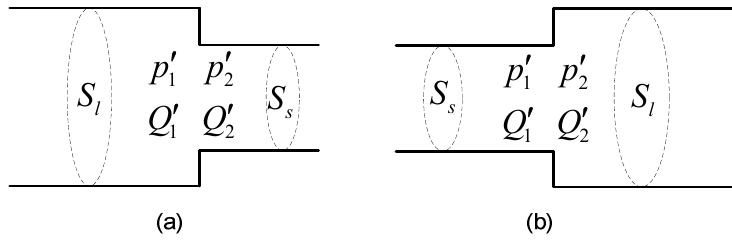
Fig. 5 Schematic of area discontinuities: (a) area contraction; (b) area expansion.